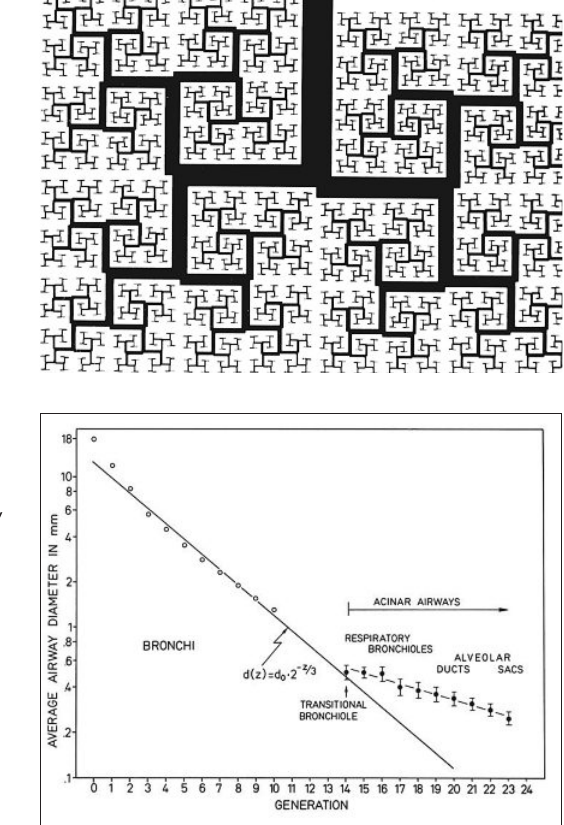
Fractal tree of Man- delbrot. From [39] by permission.